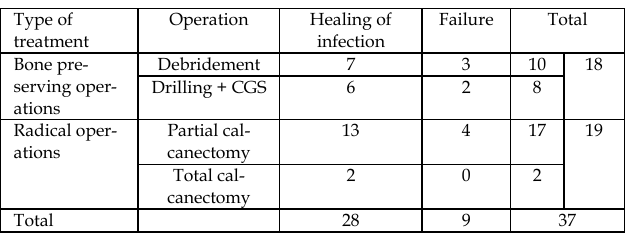
Table 2. Results of surgical treatment assigned to type of op- eration.